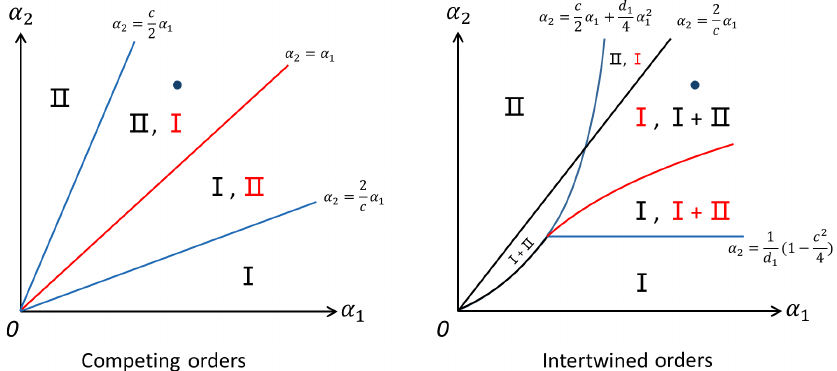
FIG. 8. Equilibrium phase diagrams on the α 1 versus α 2 plane. Black roman numeral indicates the corresponding phase is a global minimum. Red roman numeral indicates local minimum. I þ II means a minimum with both orders nonzero. The competing orders case corresponds to c > 2 and d 1 ¼ 0 . The intertwined orders case corresponds to 0 < c < 2 and d 1 > 0 . The systems are assumed to be at the blue dots in